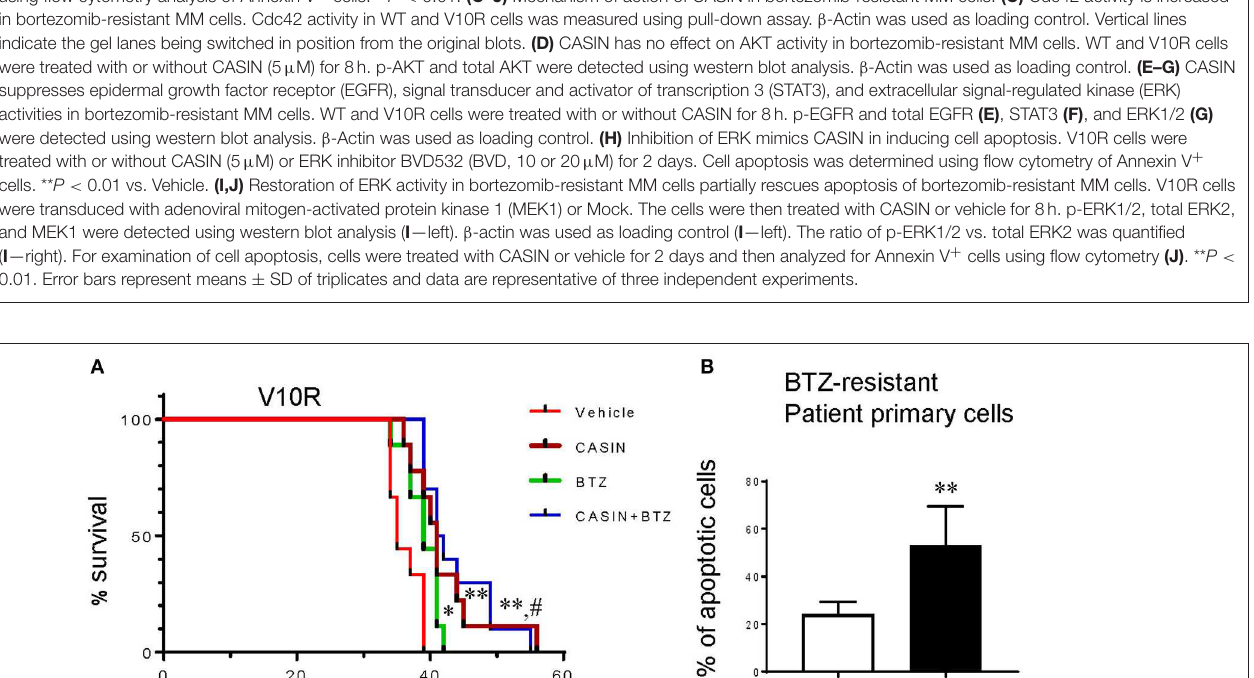
FIGURE 5 | (A) CASIN prolongs lifespan of mice bearing bortezomib-resistant MM cells. NSG mice were subjected to myeloablative busulfan conditioning followed by intrafemoral injection of V10R cells. The mice were then treated with Vehicle, CASIN, bortezomib (BTZ), or CASIN + BTZ. Mouse survival was recorded. Data were analyzed using log-rank (Mantel-Cox) test, n = 10 mice. * P < 0.05 vs. Vehicle, ** P < 0.01 vs. Vehicle and # P < 0.01 vs. BTZ. (B) CASIN causes apoptosis of primary cells from bortezomib-resistant MM patients. Human CD138 + cells were isolated from peripheral blood of bortezomib (BTZ)-resistant MM patients. The cells were treated with or without CASIN (5 µ M) for 2 days. Cell apoptosis was determined using flow cytometry analysis of Annexin V + cells. Error bars represent means ± SD of four patients, ** P <